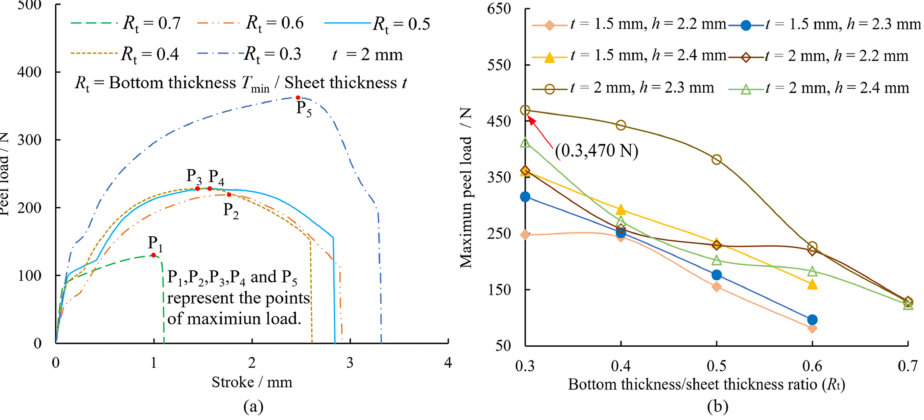
Figure 9. Variation of the peel loads on joints with ( a ) die depth h = 2.2 mm, t = 2 mm and ( b ) the bottom thickness/sheet thickness